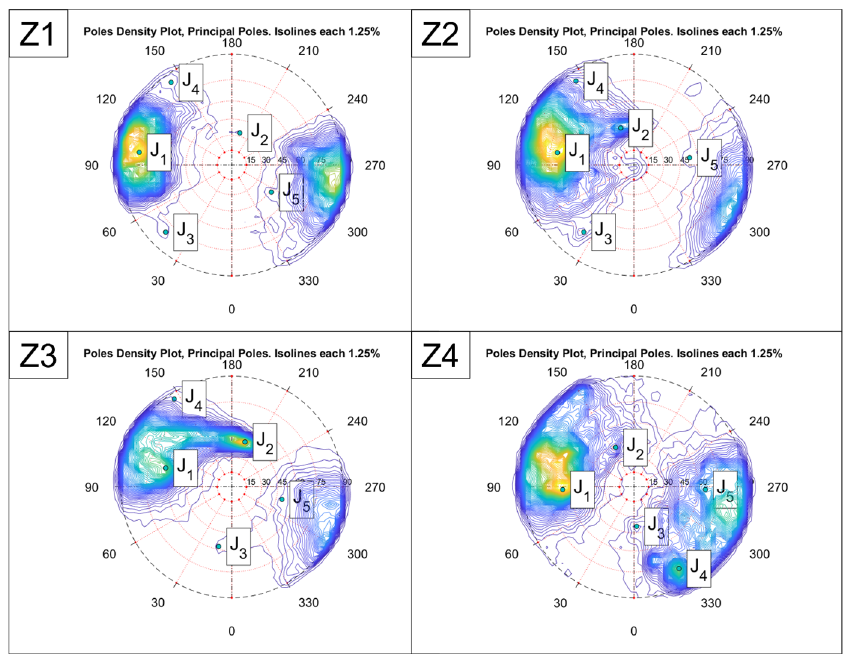
Figure 7. Stereoplot of discontinuity planes extracted utilizing DSE software at the selected source sectors. Table 2. Principal orientations of discontinuities extracted from source sectors in the 2019 SfM point cloud.